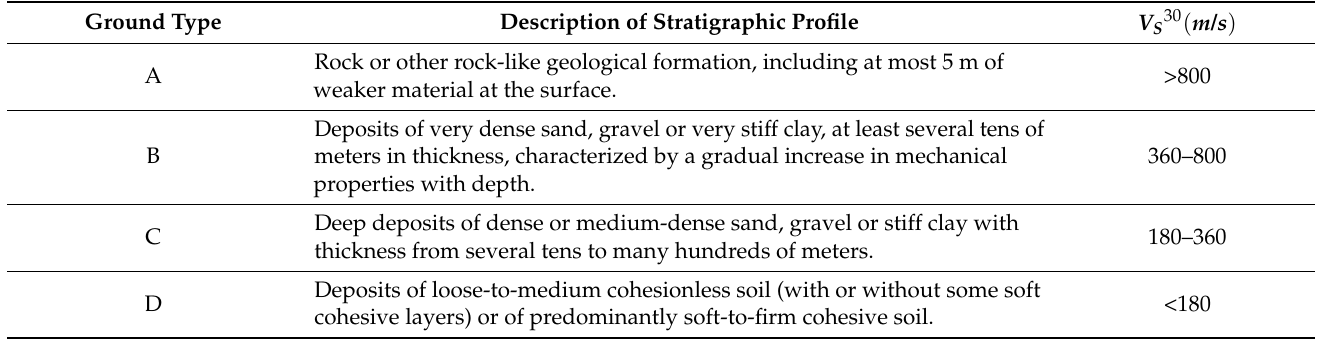
Table 1. Ground type classification based on